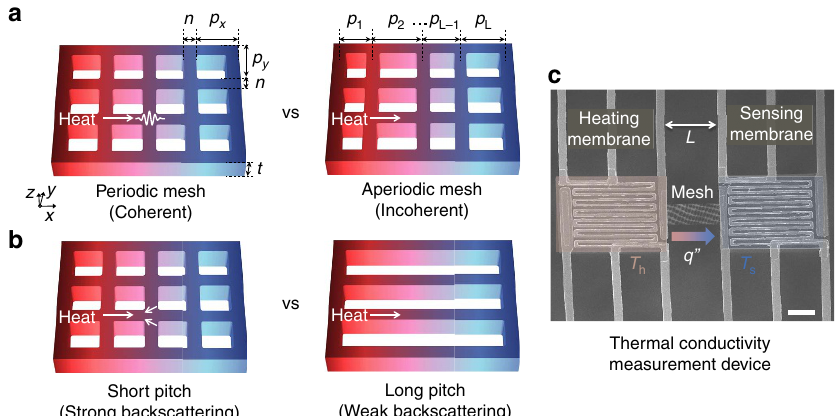
Figure 1 | Experimental designs. Design of silicon nanomeshes to investigate phonon wave coherence and particle backscattering effects, and the experimental platform. ( a ) Coherence effects are isolated by comparing periodic and aperiodic nanomeshes with identical thickness ( t ), neck size ( n ), transverse pitch ( p y ) and average pitch along the direction of heat flow (p x ), while varying the aperiodic individual pitches (p 1 , p 2 , y ) by up to ± 20% around the nominal p x ¼ 100nm. Coherence effects would be sensitive to the periodicity variations, while the boundary scattering is not. ( b ) The backscattering effect is quantified by comparing short and long pitch silicon nanomeshes with fixed p y, n and t, while varying p x between 100nm and 1 m m for different samples. The bridging necks in the short pitch nanomeshes increase the phonon backscattering as compared with the long pitch nanomeshes. Colour gradients depicting temperature gradients are illustrative in a , b . ( c ) SEM image of microfabricated suspended heater/thermometer platforms integrated with a silicon nanomesh structure of length L . The thermal conductivity k is obtained using the temperature measurements on the heating ( T h ) and sensing membranes ( T s ) and the heat flux q’’ . Scale bar, 10 m